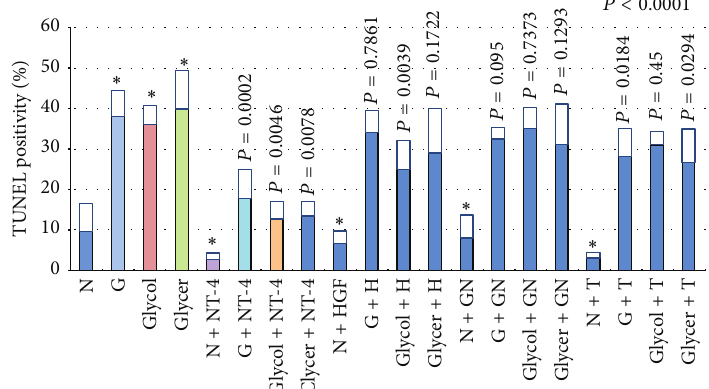
Figure 1: Graph showing the ratio of TUNEL-positive cells to all cells in the GCL of retinal explants. N, serum-free media; G, glucose-AGE- BSA; Glycol, glycolaldehyde-AGE-BSA; Glycer, glyceraldehyde-AGE-BSA; NT-4, neurotrohin-4; H, hepatocyte growth factor; GN, glial cell line-derived neurotrophic factor; T, tauroursodeoxycholic